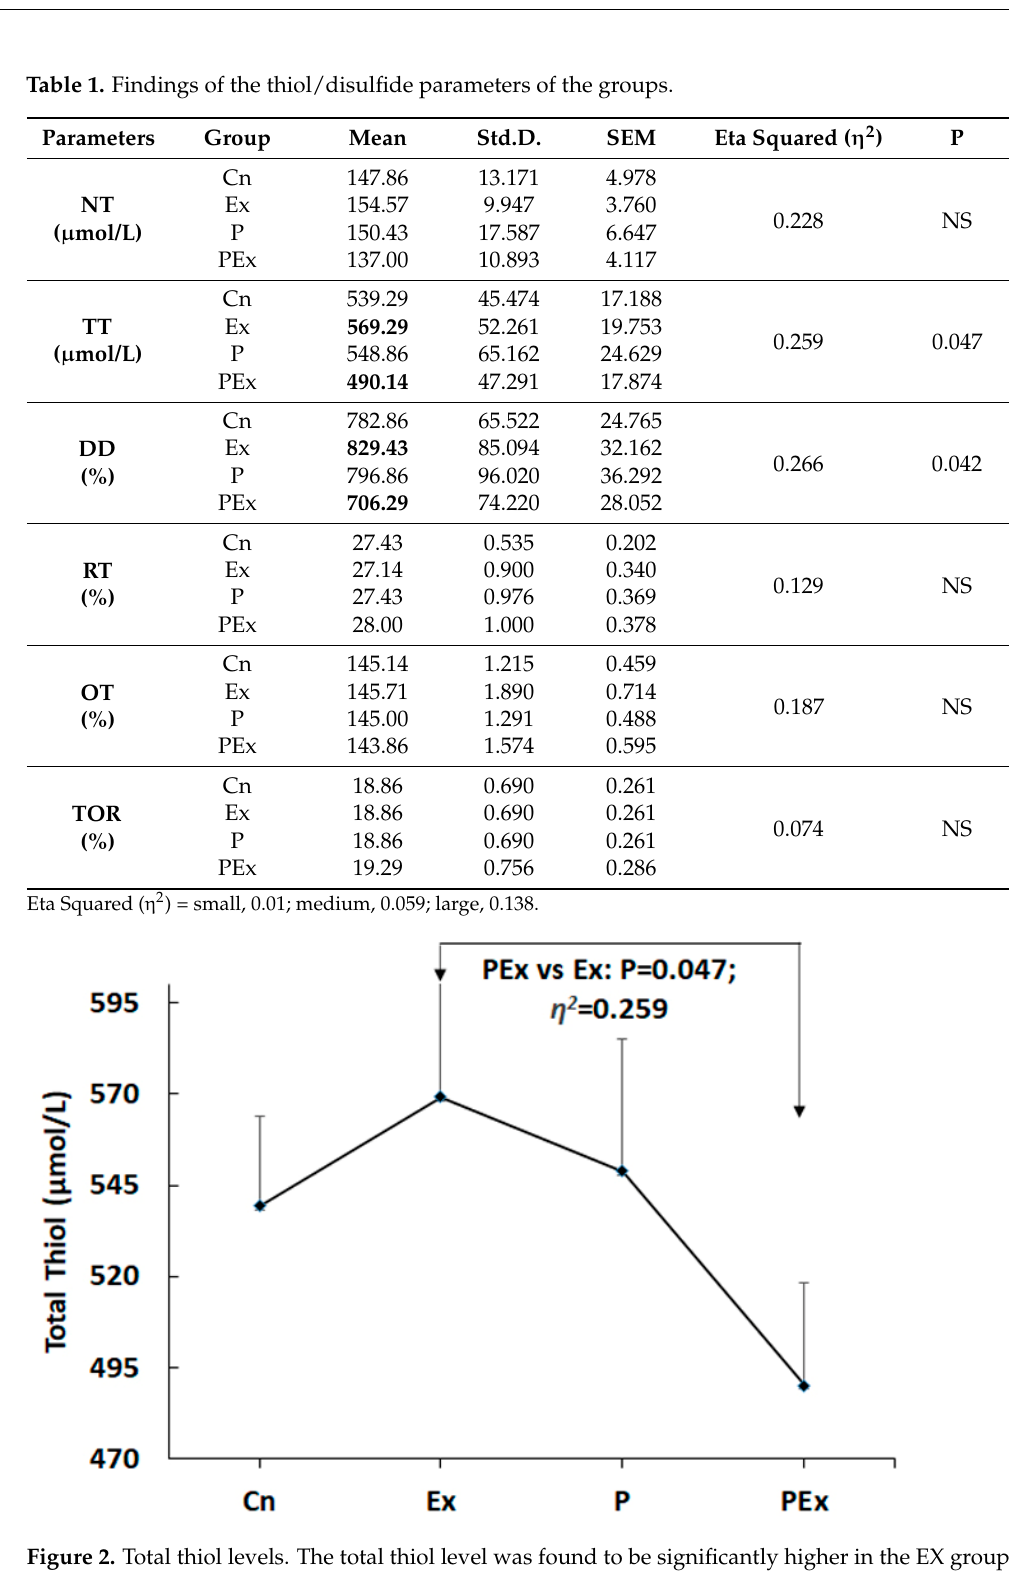
Figure 3. Dynamic disulfide levels. The dynamic disulfide level, which is considered to be an im- portant indicator of oxidation, was found to be significantly lower in the PEx group as compared with in the Ex group. In addition, it was observed that the use of probiotics alone did not have any effect on cellular oxidation. 4. Discussion In this study, the effect of probiotic supplementation on thiol/disulfide homeostasis was investigated in rats that were subjected to chronic treadmill exercise for 8 weeks. Alt- hough the effect of probiotics on oxidative stress has been investigated in studies in hu- mans and animals [15,16], no other study was found that investigated the effect of multi-